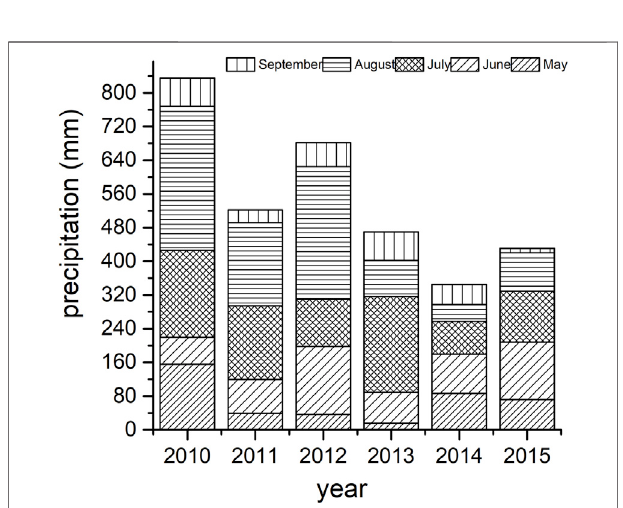
FIGURE 2 | Precipitation conditions during the maize growing season from 2010 to